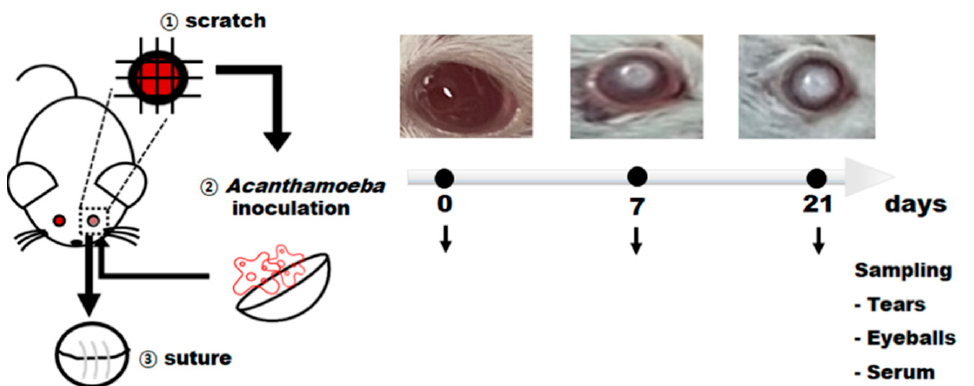
Figure 2 . Experimental design for in vivo experiments to detect Acanthamoeba spp. from AK mouse model. BALB/c mice were infected with A. castellanii trophozoites for 7 days ( n = 7) and 21 days ( n = 7). Uninfected mice (naïve) were also run in parallel ( n = 5). The tears and eyeball samples were collected from all groups were sacrificed at respective time points and used to detect Acanthamoeba antigens by ELISA. The collected sera were used to estimate anti- Acanthamoeba IgG, IgA, and IgM antibody responses.